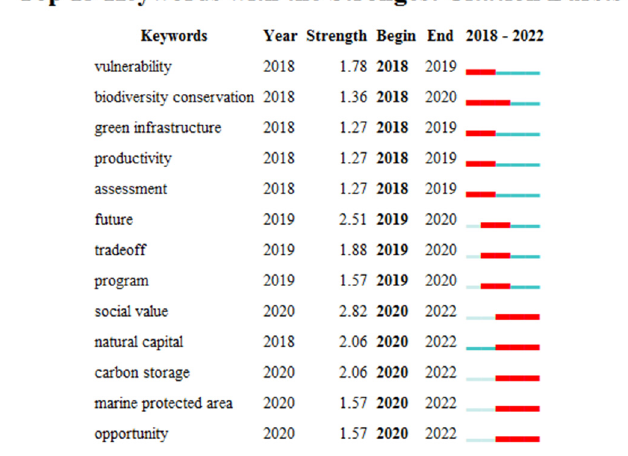
Figure 7. Keyword